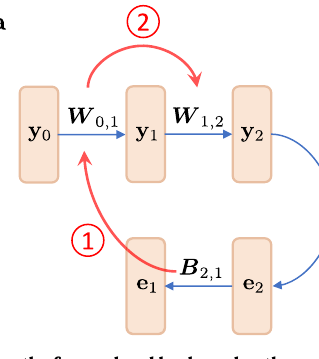
Fig. 6 | Information fl ow between the forward and backward pathways. a Both layers are trained with the rule F ð Θ Þ = θ 0 F 0 via feedback alignment. In this case, information from B 2,1 is transmitted to W 0,1 through F 0 ( ① ) and then propagated forward to W 1,2 ( ② ). b The fi rst layer is updated with the rule F ð Θ Þ = θ 0 F 0 via feedback alignment, while the second layer uses F eHebb ð Θ Þ = θ 0 F 0 + θ 2 F 2 . Using